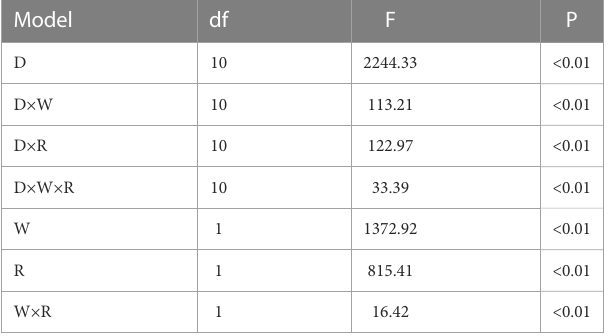
TABLE 2 Results ( df , F and P ) of repeated measures analysis of variances (RMANOVA) for the separate and interactive effects of warming (W), reclamation (R), sampling day (D) on soil N 2 O emission fl